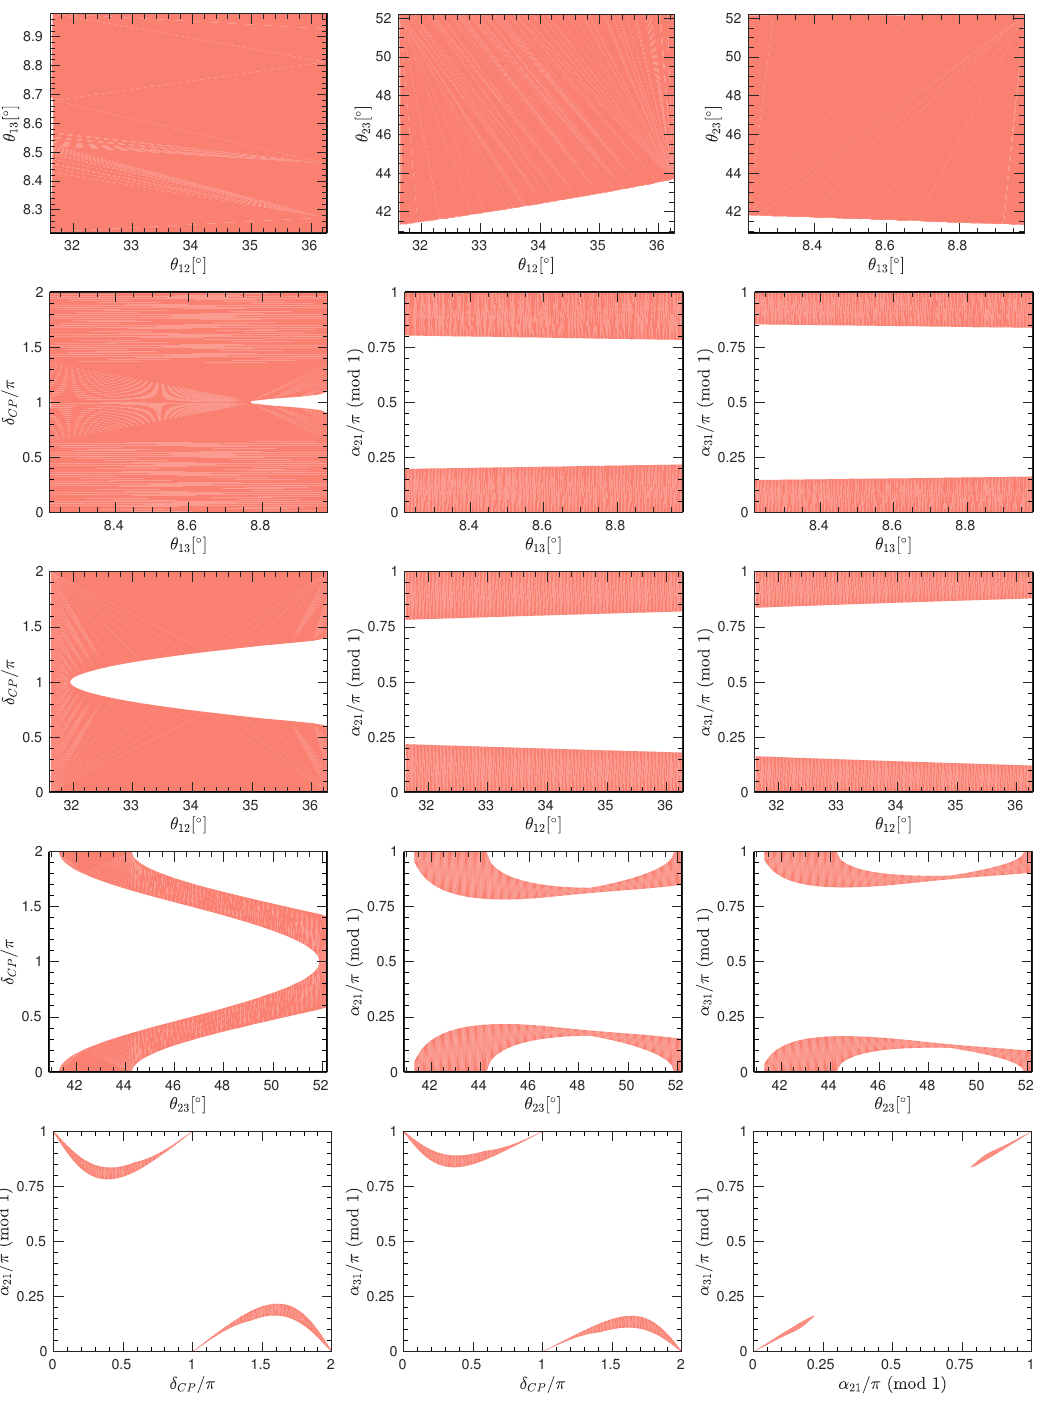
Figure 3 . Correlations between di(cid:11)erent mixing parameters for the mixing pattern U II; 8 with ’ 1 = 2 (cid:25)= 7 which can be achieved from the D 7 (cid:13)avor group, and the three lepton mixing angles are required to lie in their 3 (cid:27) ranges [2].